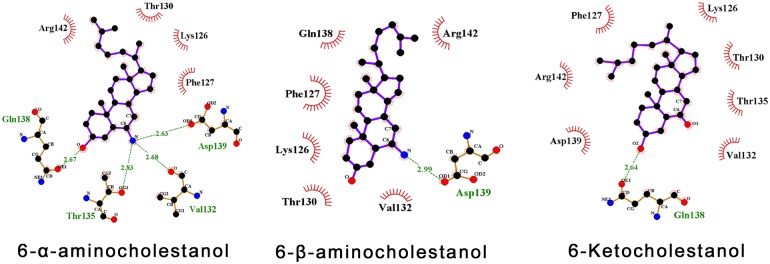
Interaction diagrams of compounds 6-α-aminocholestanol (20), 6-β-aminocholestanol and 6-ketocholestanol (48) (from left to right) with pocket P2 on apo-LieIF, in the non-phosphorylated form.Hydrogen bonds are shown in green dashed lines along with their length in Å. Residues establishing hydrophobic interactions with the ligands atoms are shown in red incomplete circles. Ligand atoms of the compound that are implicated in these hydrophobic interactions are also surrounded by red sticks.